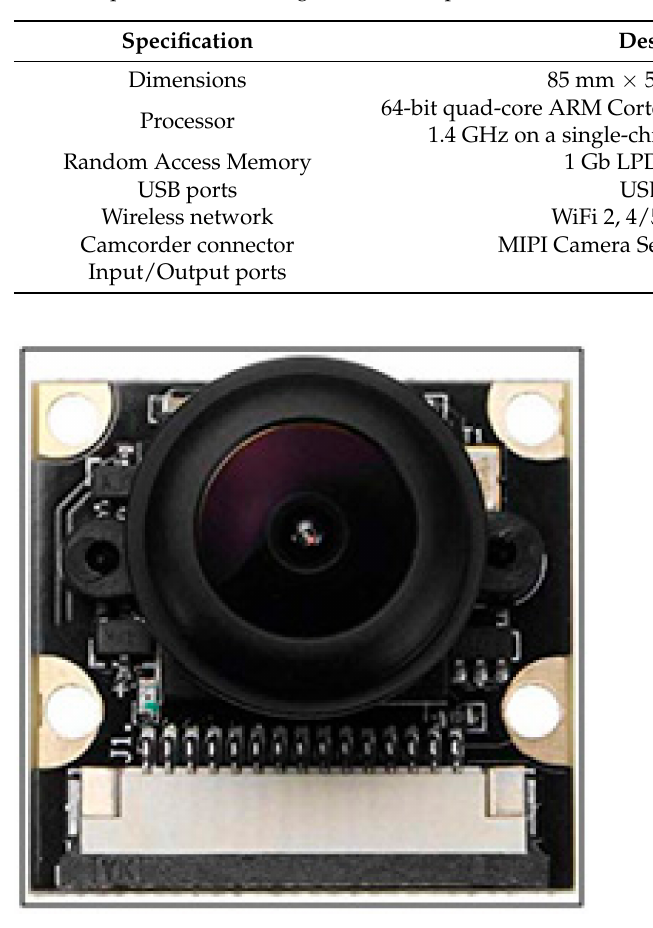
Table 1. Specifications of Single Board Computer.